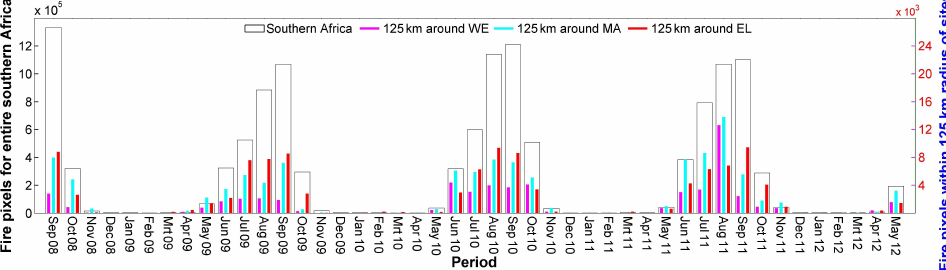
Figure 7. Fire pixels within the entire southern Africa domain (10–35 ◦ S, and 10–41 ◦ E) indicated on the primary y axis, as well as fires pixels within a radius of 125km around Elandsfontein (EL), Marikana (MA) and Welgegund (WE) measurement sites indicated on the secondary y axis, as determined from the MODIS collection 5 burned area product (Roy et al.,